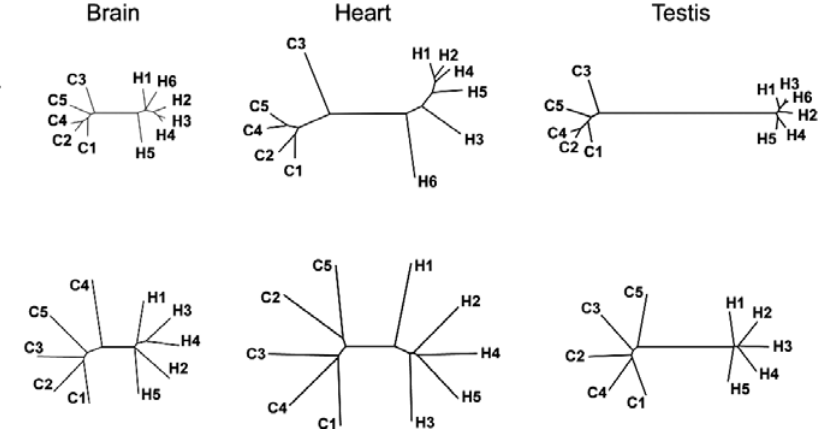
Figure 4. Schematic Representation of Expression Diversity and Divergence in Humans and Chimpanzees in the Three Tissues The expression was measured using either ‘‘ classical ’’ transcript-based arrays (upper row) or exonic probes on the tiling arrays (lower row). The trees are inferred from the mean of the squared difference of expression intensities of all detected probe sets [16] or all expressed exonic probes (Materials and Methods). Greater variation observed within species for the exonic probe expression is likely due to greater technical variation associated with tiling arrays measurements, caused by probe design limitations, and by the fact that tiling array measurements are based on signal probe intensity and not on the cumulative intensity of a set of probes. DOI: